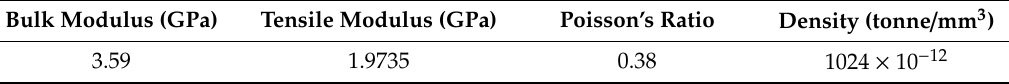
Table 2. The elastic material parameters of ABS used in